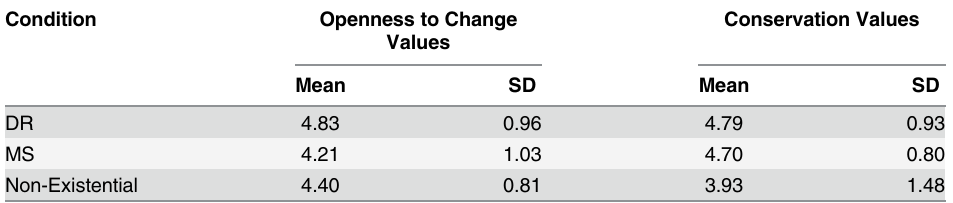
Table 2. Means and Standard Deviations for Openness to Change and Conservation Values as a Function of Condition in Experiment 2.